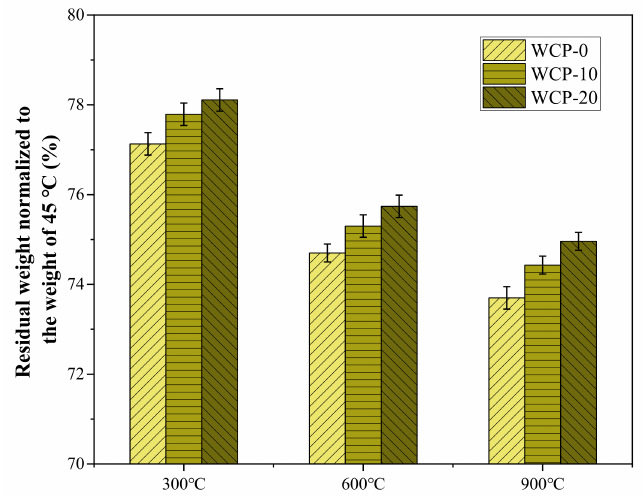
Figure 4. Residual weight of sample normalized to the weight of 45 ◦